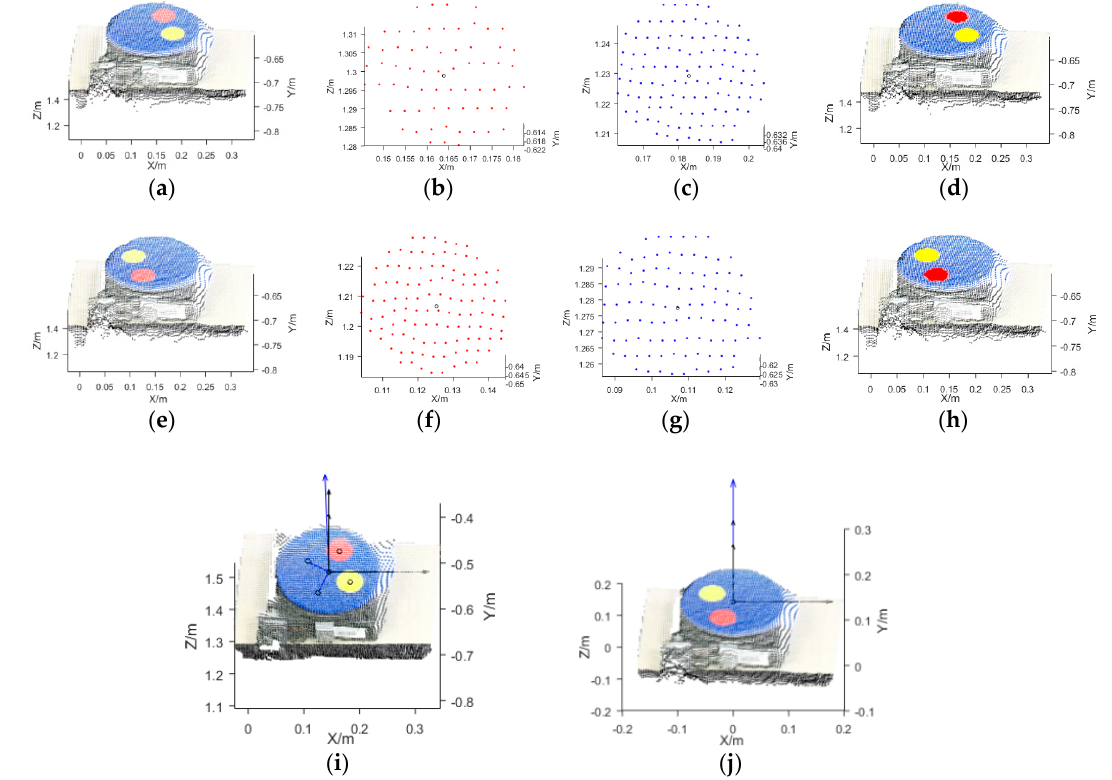
Figure 2. Calibration of the Kinect sensor position. ( a ) Segmentation of the point cloud of the turntable (0°); ( b ) Point cloud of the red calibration label (0°); ( c ) Point cloud of the yellow calibration label (0°); ( d ) Identification of the calibration labels (0°); ( e ) Segmentation of the point cloud of the turntable (180°); ( f ) Point cloud of the red calibration label (180°); ( g ) Point cloud of the yellow calibration label (180°); ( h ) Identification of the calibration labels (180°); ( i ) Normal vector of the axis of rotation of the turntable (original coordinates); ( j ) Normal vector of the axis of rotation of the turntable (after transformation).